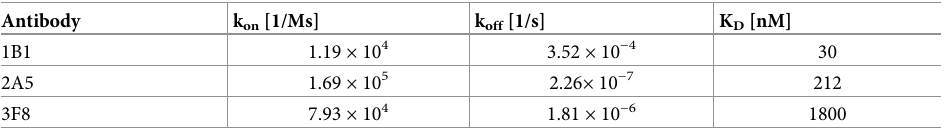
Table 2. Binding kinetics of antibodies to HLA-E7 peptide complex measured by SPR, as described in the